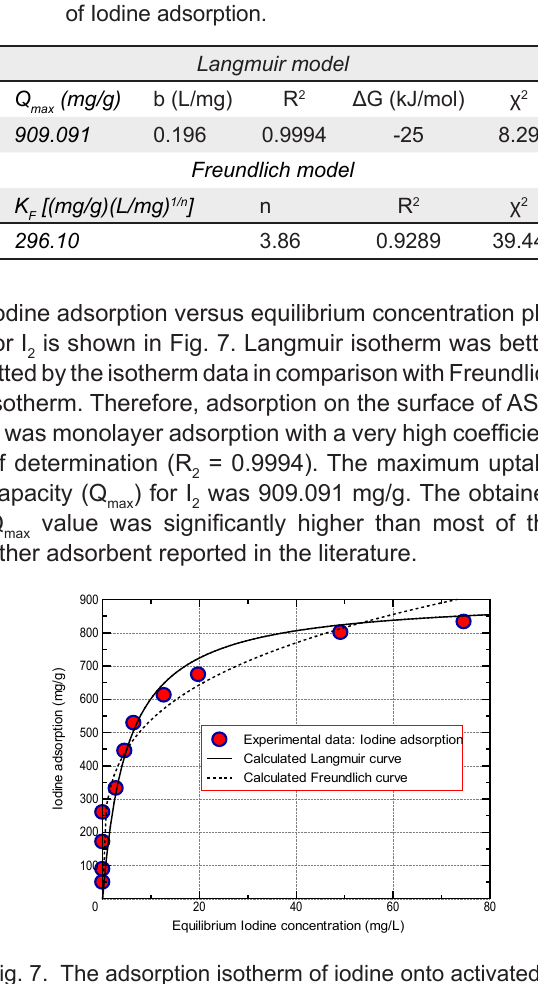
Fig. 7. The adsorption isotherm of iodine onto activated carbon obtained from